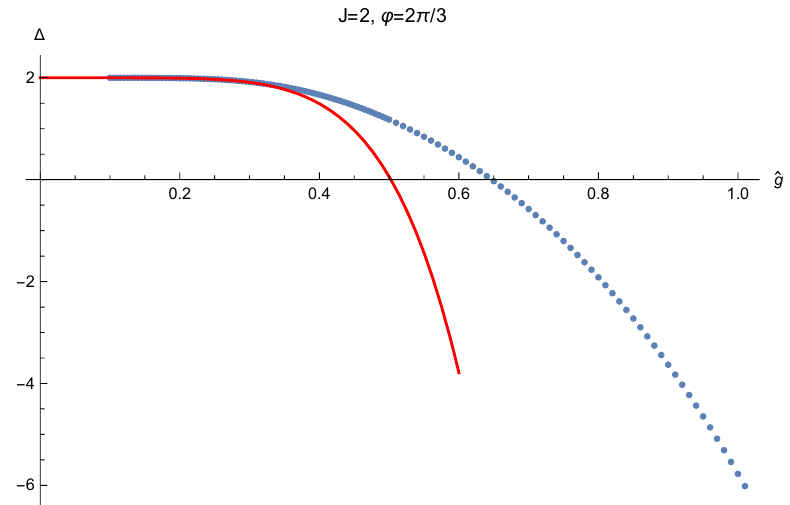
Figure 14. Numerical data (dots) for the ground state of length-2 chain with ϕ = 2 π/ 3 . Red solid line shows the Lüscher formula prediction of